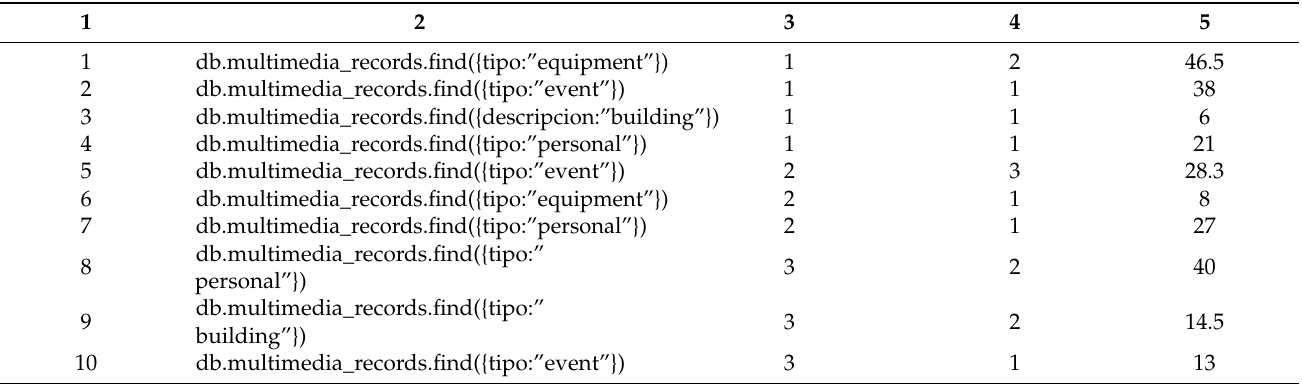
Table 3. Operations performed on the centralized multimedia database.